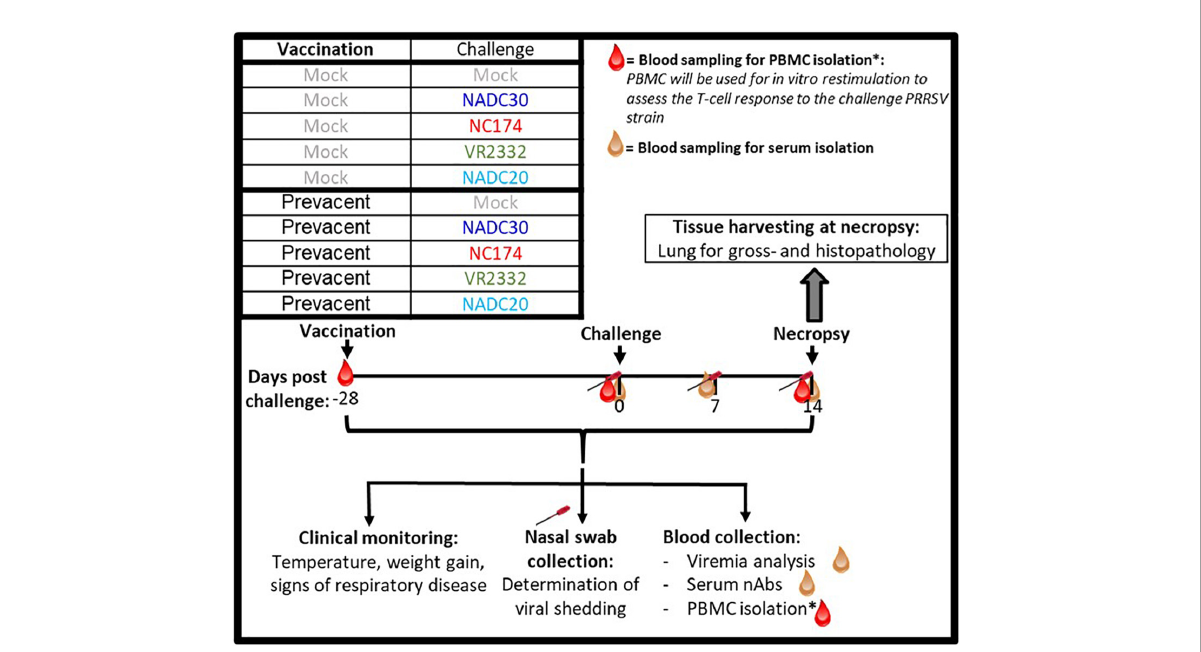
FIGURE1 Layout of the PRRSV-2 vaccination and challenge animal trial. Four-week old weaner pigs were distributed into 10 groups—five MOCK– and five Prevacent-vaccinated groups. Pigs were vaccinated at –28 days post challenge (dpc). At day of challenge (0 dpc), each of the five groups received one of five intranasal inoculations—MOCK, NADC30, NC174, VR2332, or NADC20. At 14 dpc, pigs were sacrificed to assess lung pathology. As indicated in the timeline, blood and nasal swabs were collected throughout the study to assess viral loads as well as the humoral and T-cell immune